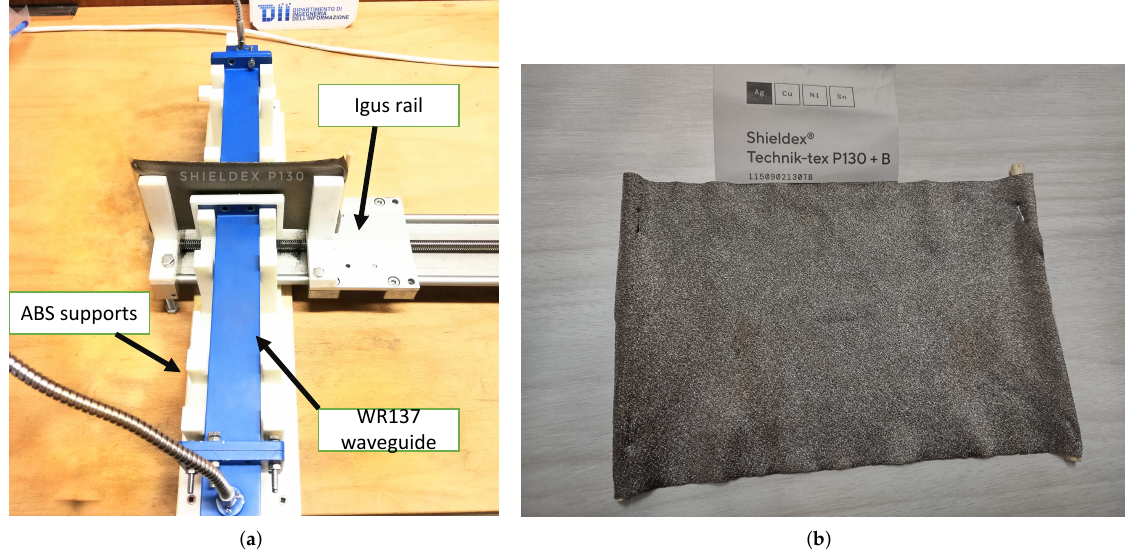
Figure 6. ( a ) Experimental setup; ( b ) stretchable